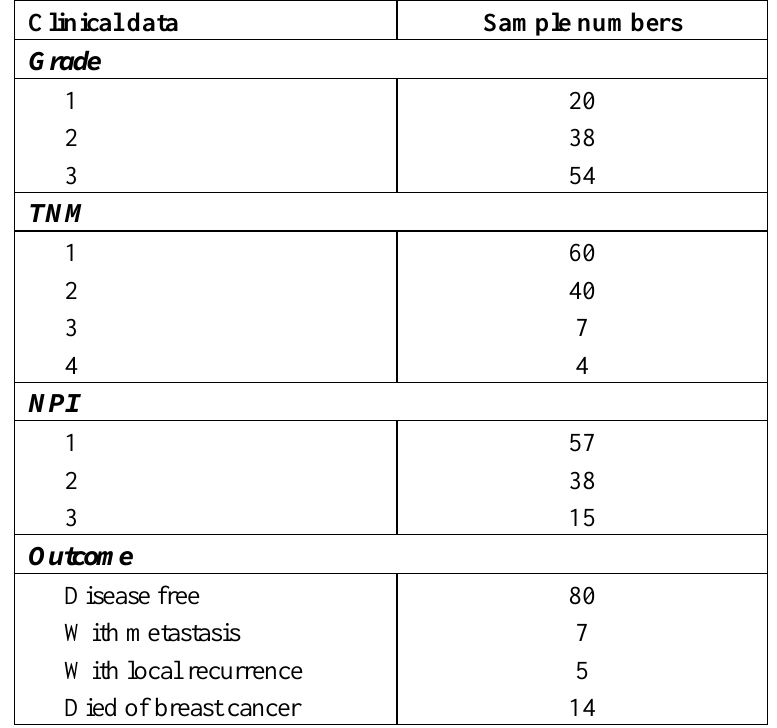
Table 1. Clinical and pathological information of the breast cancer